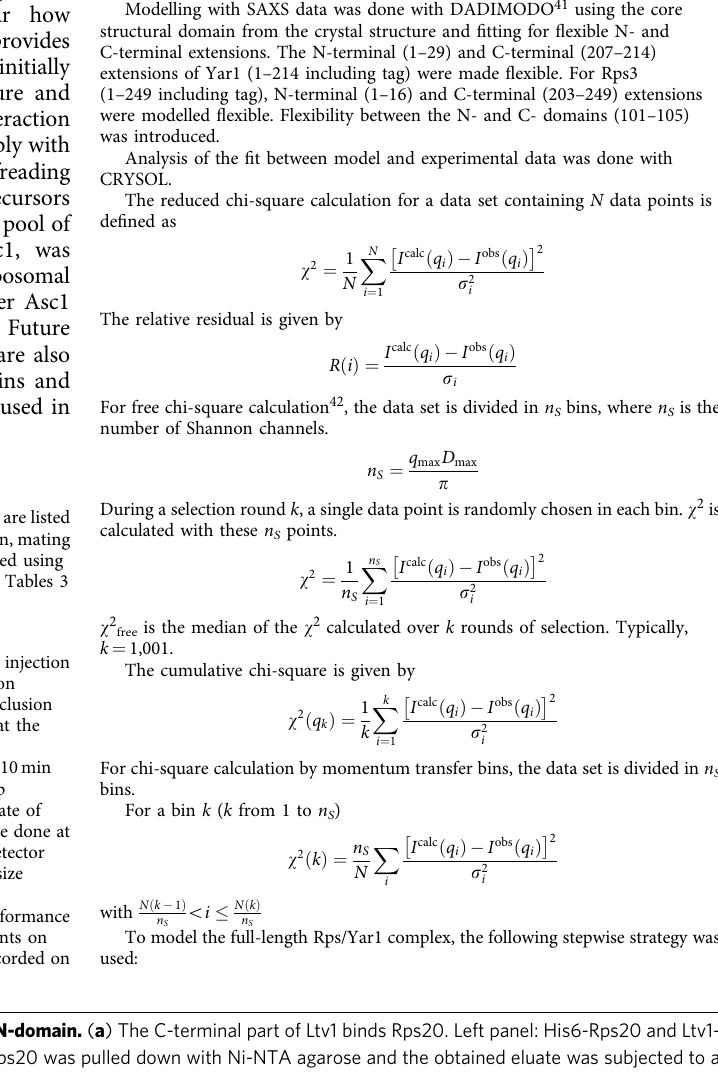
Right panel: after co-expression of His6-Rps20 with the indicated Flag-tagged N- and C- terminal Ltv1 truncations in E. coli , cell lysates were subjected